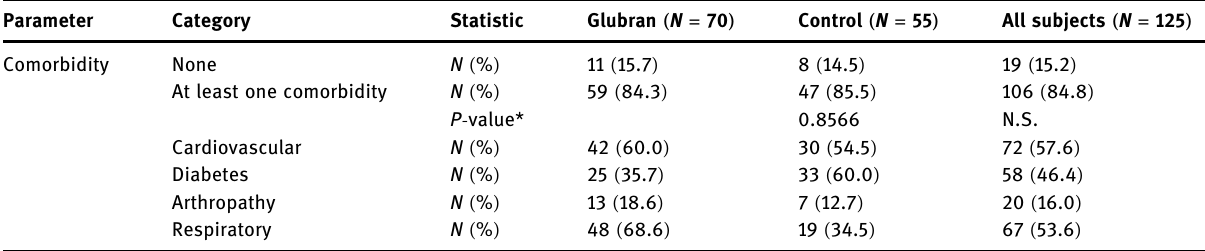
*Chi - square test.